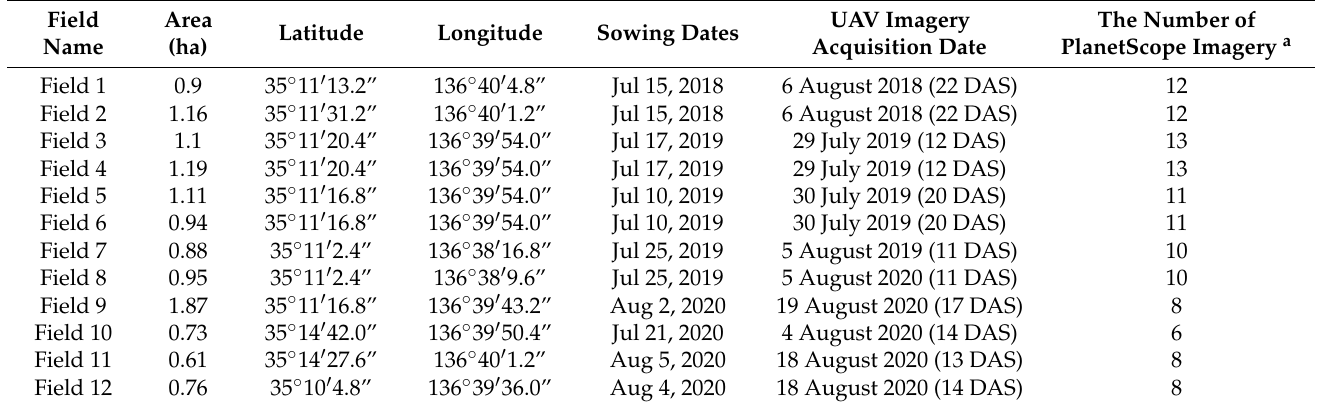
Table 1. Locations, sowing dates, UAV imagery acquisition dates, and the number of satellite (PlanetScope) imagery used for all observation